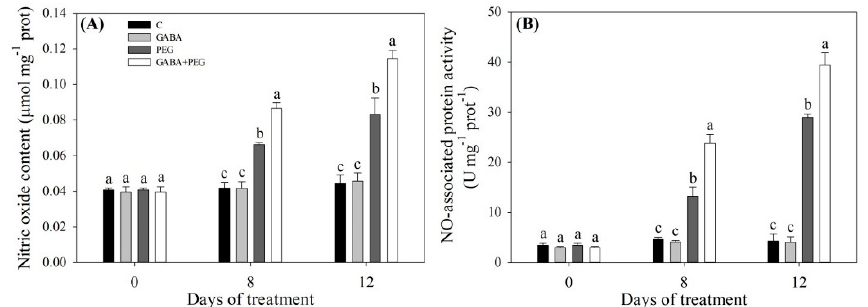
Figure 7. Effects of exogenous γ -aminobutyric acid (GABA) pretreatment on ( A ) nitric oxide content, ( B ) NO-associated protein activity in leaves of creeping bentgrass under non-stress and water stress conditions. Vertical bars indicate ± SE of mean ( n = 4). Different letters above columns indicate significant difference at a particular day based on the LSD ( P ≤ 0.05). C, well-watered control; GABA, well-watered control pretreated with GABA; PEG, PEG-induced water stress; GABA + PEG, water-stressed plants pretreated with GABA.